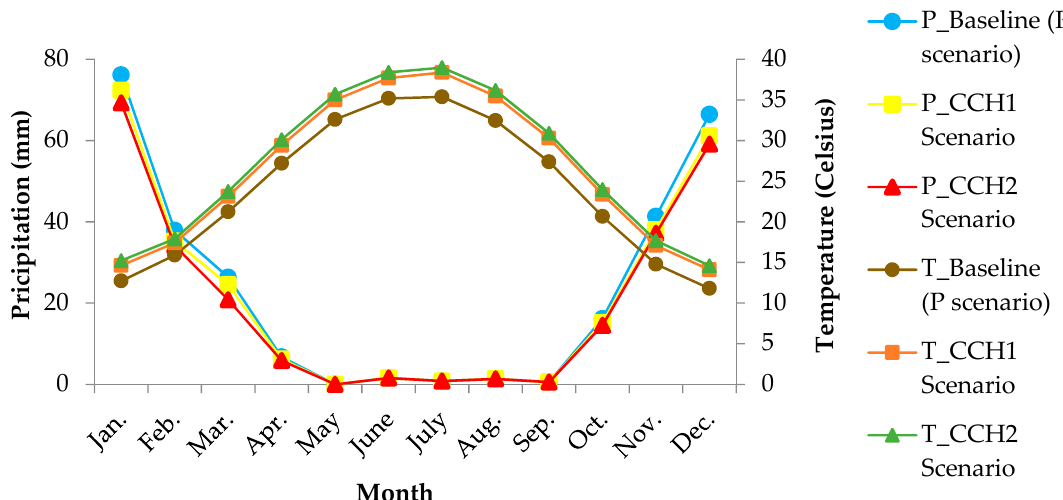
Figure 2. Change in monthly precipitation (P), and monthly air temperature (T) under three climate scenarios, P, CCH1 and CCH2.